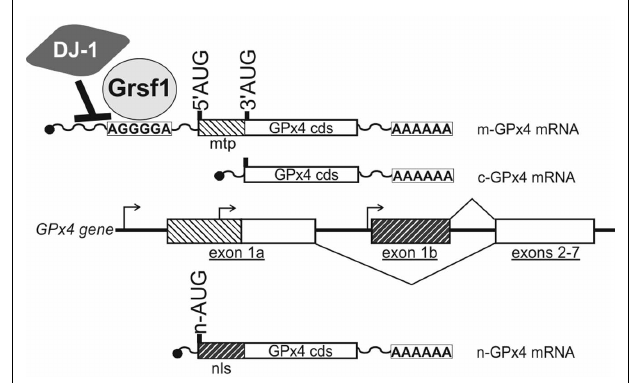
FIGURE 2 | Coding multiplicity of the GPx4 gene. The GPx4 gene gives rise to three isoenzymes designated m-GPx4, c-GPx4, and n-GPx4.They can be distinguished by their N-terminal sequences that determine their subcellular localization [mtp, mitochondrial targeting peptide (light hatching); nls, nuclear localization sequence (dark hatching)].The mammalian GPx4 gene consists of seven exons and contains three windows of transcriptional (arrows) and translational (5 (cid:3) AUG, 3 (cid:3) AUG, n-AUG) initiation, that are specific to the isoenzymes.Two protein factors (DJ-1, Grsf1) have been identified that affect post-transcriptional regulation of the GPx4 gene. cds, coding sequence.